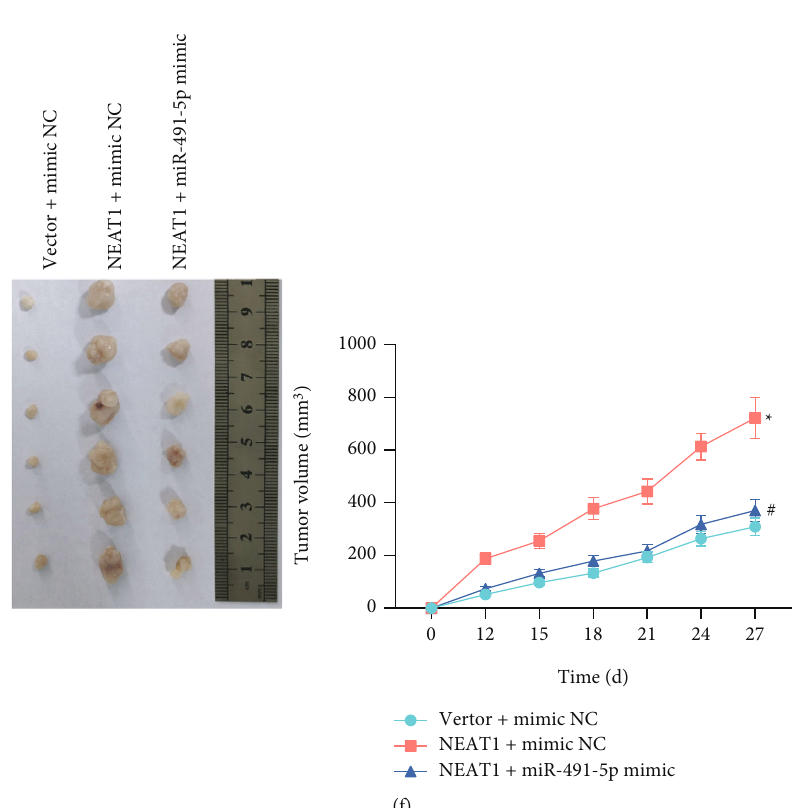
Figure 5: E ff ect of NEAT1 and miR-491-5p on PCa cell activities and gemcitabine resistance. SW1990 cells were transduced with overexpression vector-mediated NEAT1 alone or combined with miR-491-5p. (a) Expression of NEAT1 and miR-491-5p determined by RT-qPCR. (b) Clonogenic potential of SW1990 cells detected by colony formation assay. (c) Migration of SW1990 cells detected by Transwell assay. (d) Expression of EMT-related genes (E-cadherin, vimentin, and fi bronectin) of SW1990 cells measured by RT-qPCR. (e) Resistance of SW1990 cells to gemcitabine detected by MTS assay. (f) Tumorigenicity of SW1990 cells in mice ( n = 6 ). ∗ p < 0 : 05